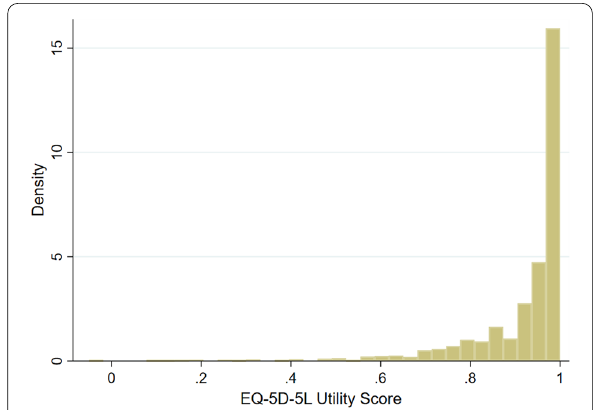
Fig. 1 Distribution of EQ-5D-5L utility